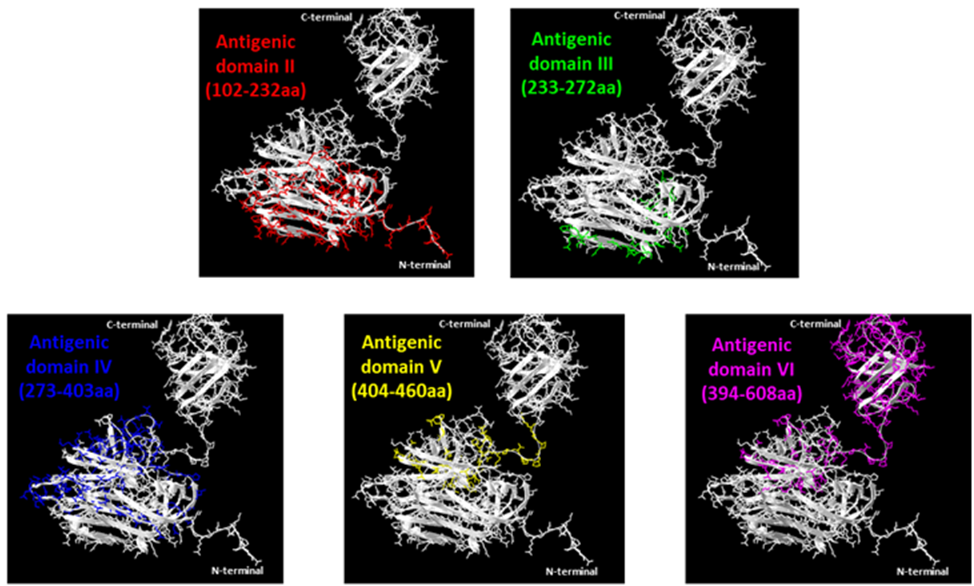
Figure 3. Ribbon diagrams of crystal structures of ORF2 capsid protein (118–606 aa) (PDB accession code: 2ZZZQ). Five of the six domains identified are indicated with different colors. The pictures were obtained by SwissPdb Viewer [24].